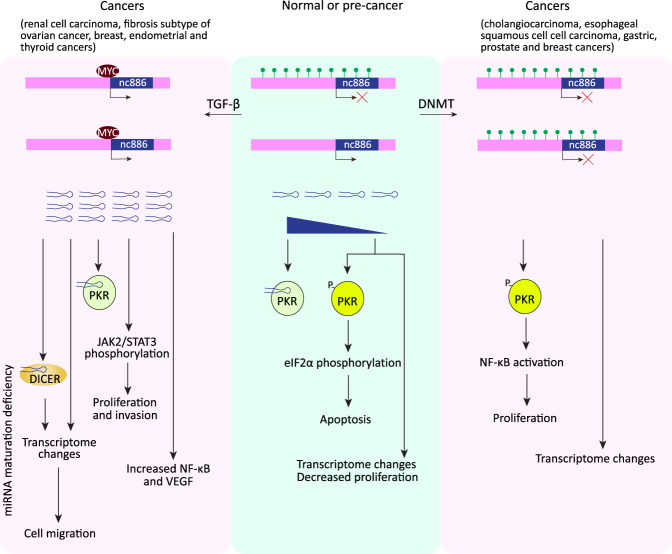
nc886 and cancer. In normal cells, the nc886 locus is methylated in an allele-specific manner but nc886 RNA levels are sufficient to inactivate PKR by direct association. If nc886 levels decrease, PKR can become activated leading to apoptosis, and transcriptional changes can lead to reduced cell proliferation (Kunkeaw et al. 2013; Lee et al. 2014a,b; Lee et al. 2016). In some cancers, nc886 expression is suppressed by progressive DNMT-dependent hypermethylation of its locus, which leads to NF-κB activation and increased cell proliferation as well as to PKR-independent transcriptome changes (Kunkeaw et al. 2013; Lee et al. 2014a,b; Fort et al. 2018). Alternatively, nc886 levels can be increased either by binding of MYC to the demethylated allele (Park et al. 2017) or by TGF-β (transforming growth factor β) activation leading to demethylation of the second allele (Ahn et al. 2018). This has several consequences: increased cell migration as a result of transcriptome changes and as a result of DICER inhibition, also leading to transcriptome changes; inhibition of PKR; increased cell proliferation and invasion through activation of the JAK2/STAT3 pathway; and activation of NF-κB and VEGF (vascular endothelial growth factor) (Hu et al. 2017; Lei et al. 2017; Ahn et al. 2018).